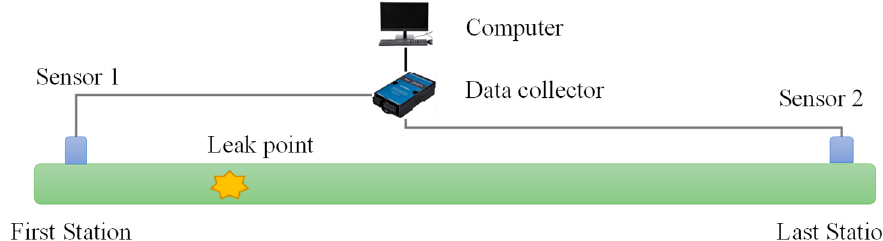
Figure 3. Experimental schematic.